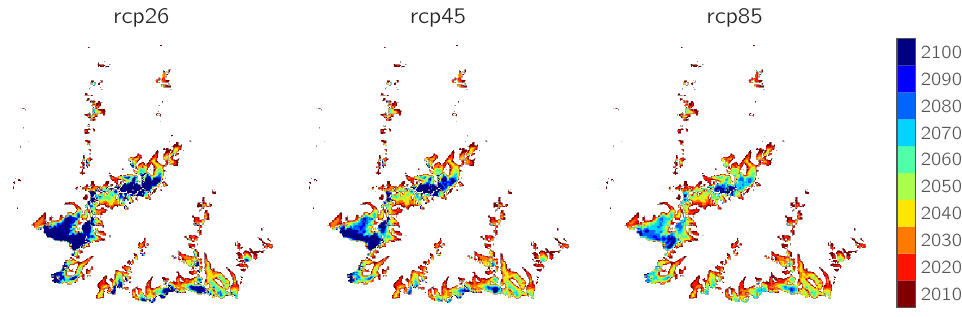
Figure 14. Spatially distributed simulated glacier coverage (multi-model mean) shown in 10-year intervals for the three RCPs.